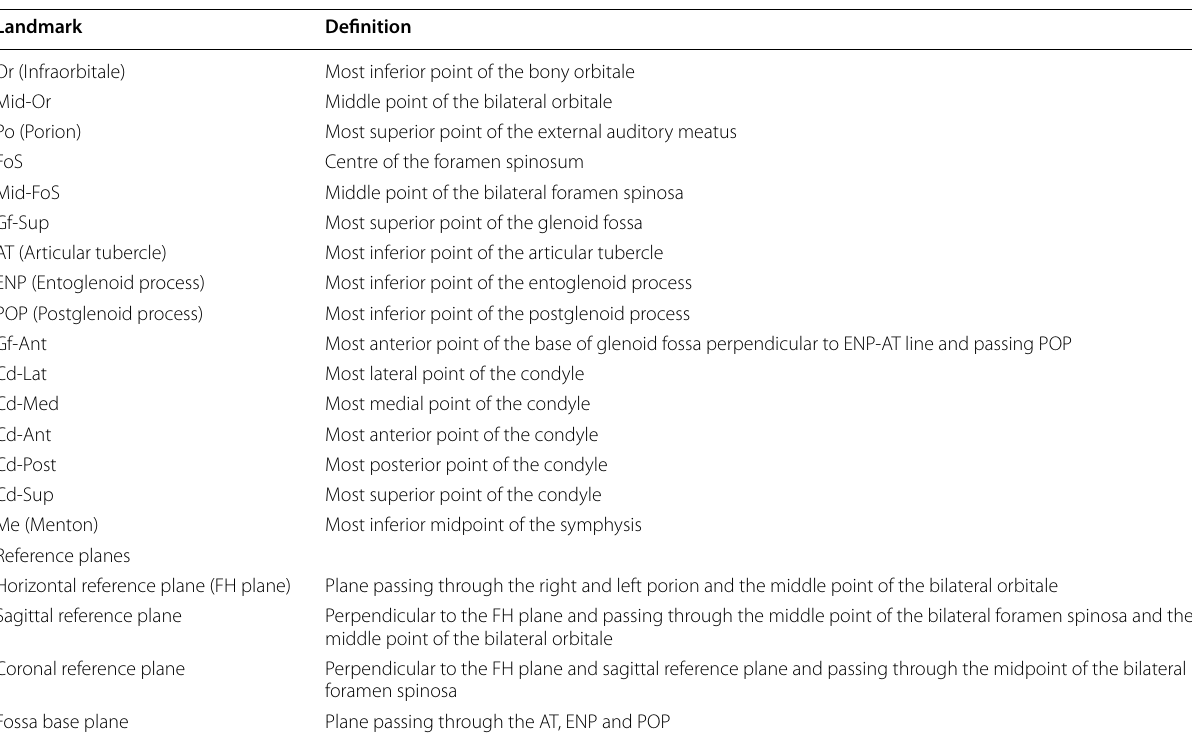
Table 1 Definitions of anatomical landmarks and reference